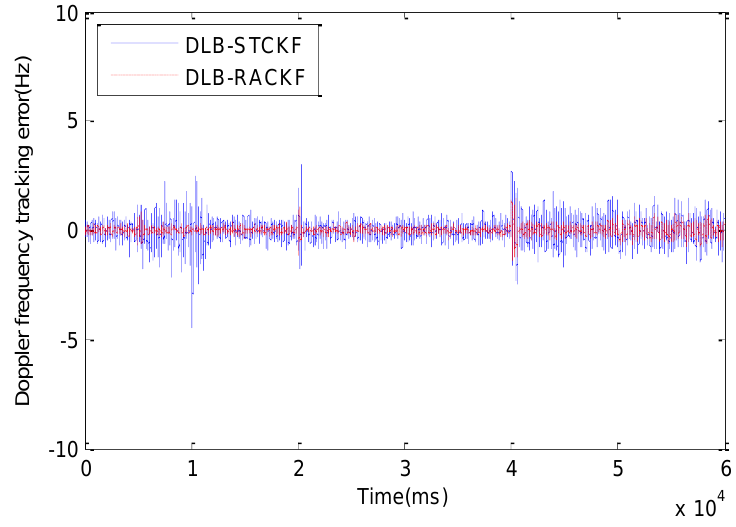
Figure 6. Comparison of code phase tracking error among DLB-STCKF and DLB-RACKF.